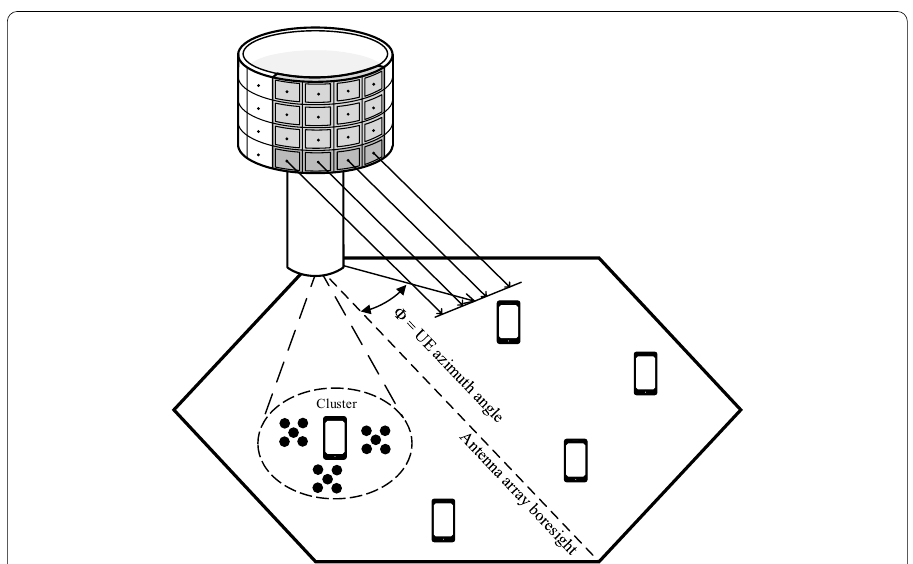
Fig. 1 A cellular transmission model using the uniform circular